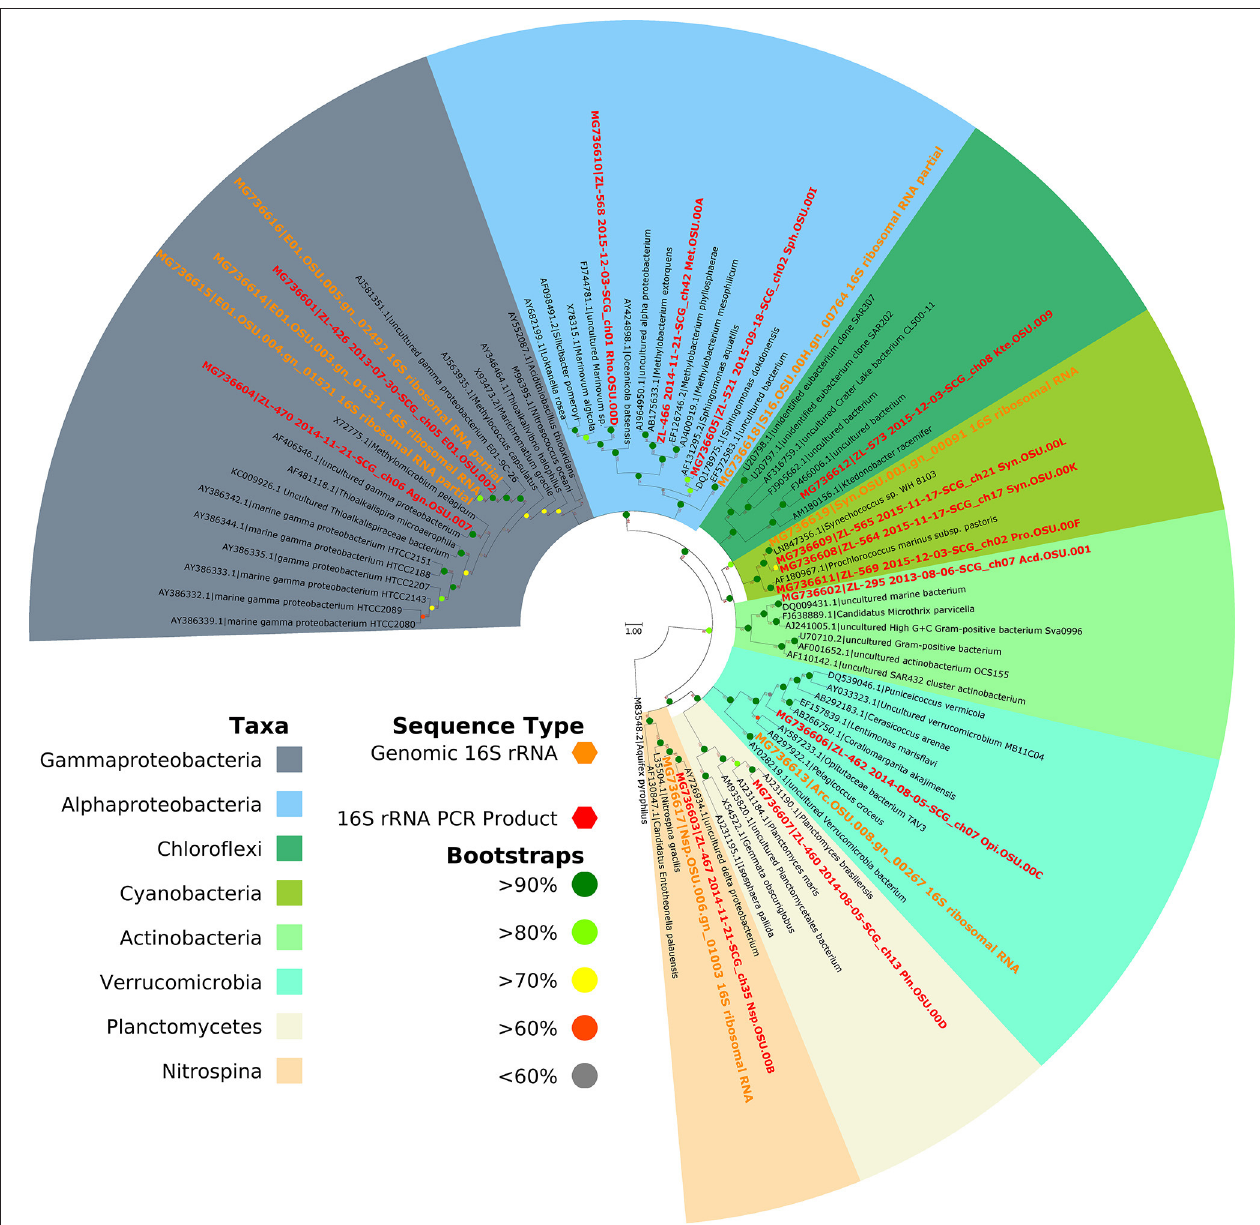
FIGURE 2 | Phylogeny of SAG 16S rRNAs . Clades are color-coded by taxonomy as marked in the key. The scale bar represents 0.03 substitutions per site. Cells from a total of 7 phyla are represented in our data set, indicating that optofluidics is compatible with a number of cell